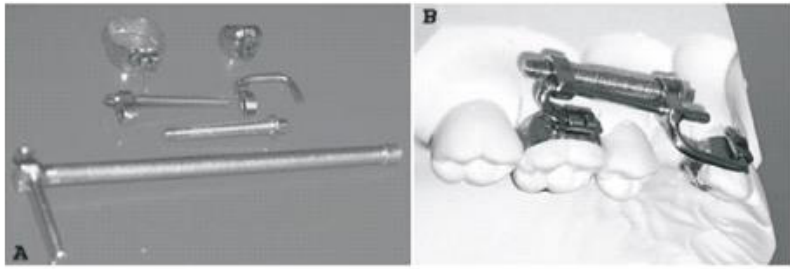
Figure 22: Canine retraction using distractor of periodontal